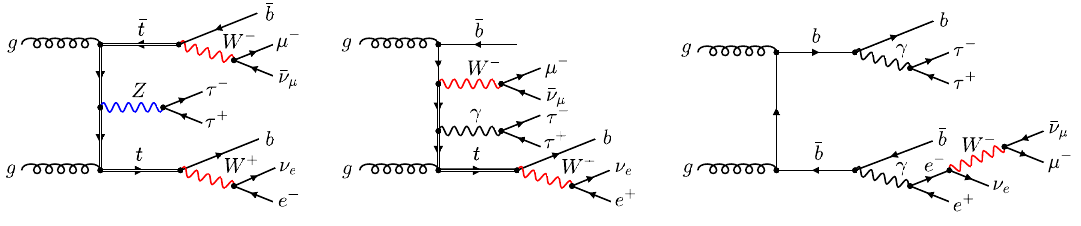
Figure 1 . Representative Feynman diagrams with double- (left), single- (middle) and no top-quark resonances (right) contributing to the gg → e + ν e µ − ¯ ν µ b ¯ b τ + τ − partonic subprocess at leading order. The middle and right diagram comprise no Z resonances whereas the third one involves only a single W boson. They contribute to Z and W off-shell effects.